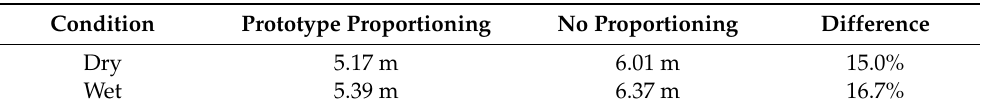
Table 5. Combined CPSC and ISO stopping distance simulation test for the e-bike tested with and without the prototype proportioning